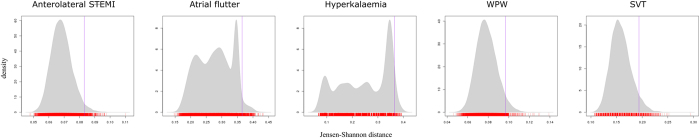
JS distance permutation distributions (vertical line represents correct/incorrect distance).